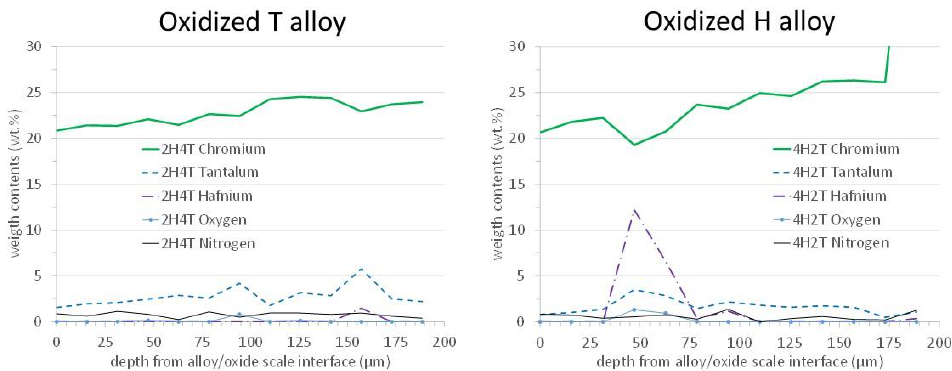
Figure 13. Concentration profiles acquired from the external surface into the alloy ( left : T alloy, right : H alloy).